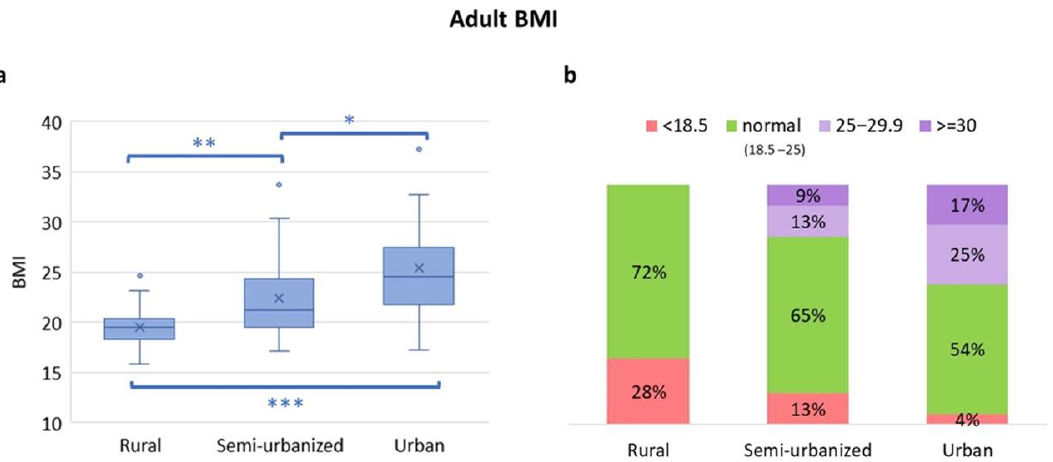
Figure 6. Comparison of the BMI categories among adults from rural, semi-urban and urban areas. ( a ) BMI distribution. Boxplots show median and interquartile range. “x” is the mean and blue dots are outliers. Statistically significant by Mann – Whitney test *** p ≤ 0.001, ** p ≤ 0.01, * p ≤ 0.05. ( b ) Proportion of adults with underweight (BMI < 18.5 kg/m 2 ), normal weight (BMI 18.5 – 25 kg/m 2 ), overweight (BMI 25 – 29.9 kg/m2) and obesity (>30 kg/m 2 ) across the areas. In Supplementary Material Table S6, adults’ BMI score divided by gender is reported.